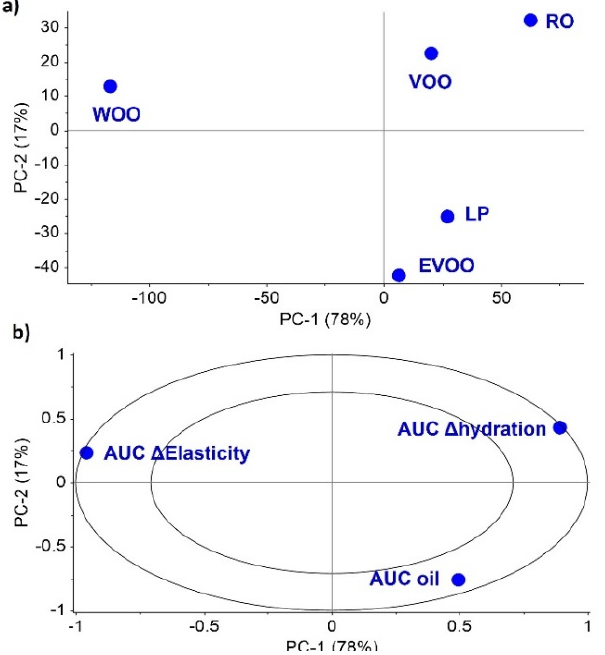
Figure 7. PCA analysis of AUC ∆ oil, AUC ∆ hydration and AUC ∆ elasticity features. ( a ) Scores; ( b ) Correlation loadings.